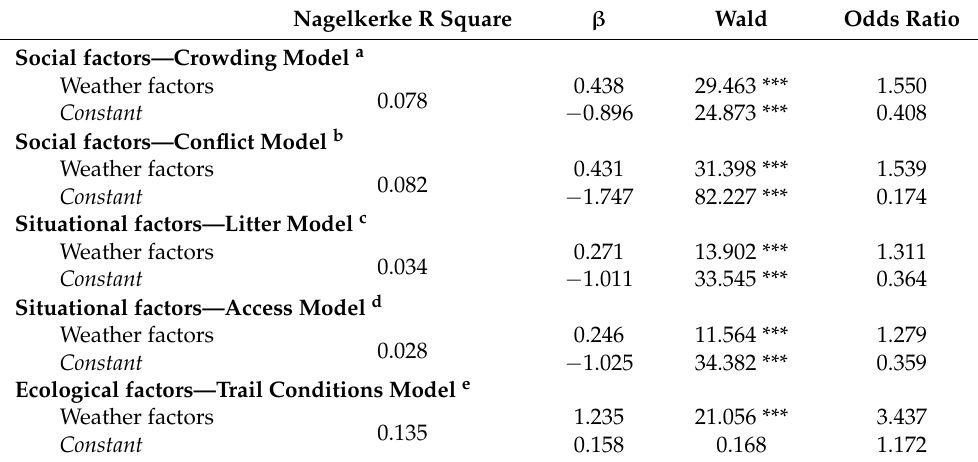
Table 4. Binary Logistic Regression Models—Predicting LBW Visitor Perceptions of Impacts.